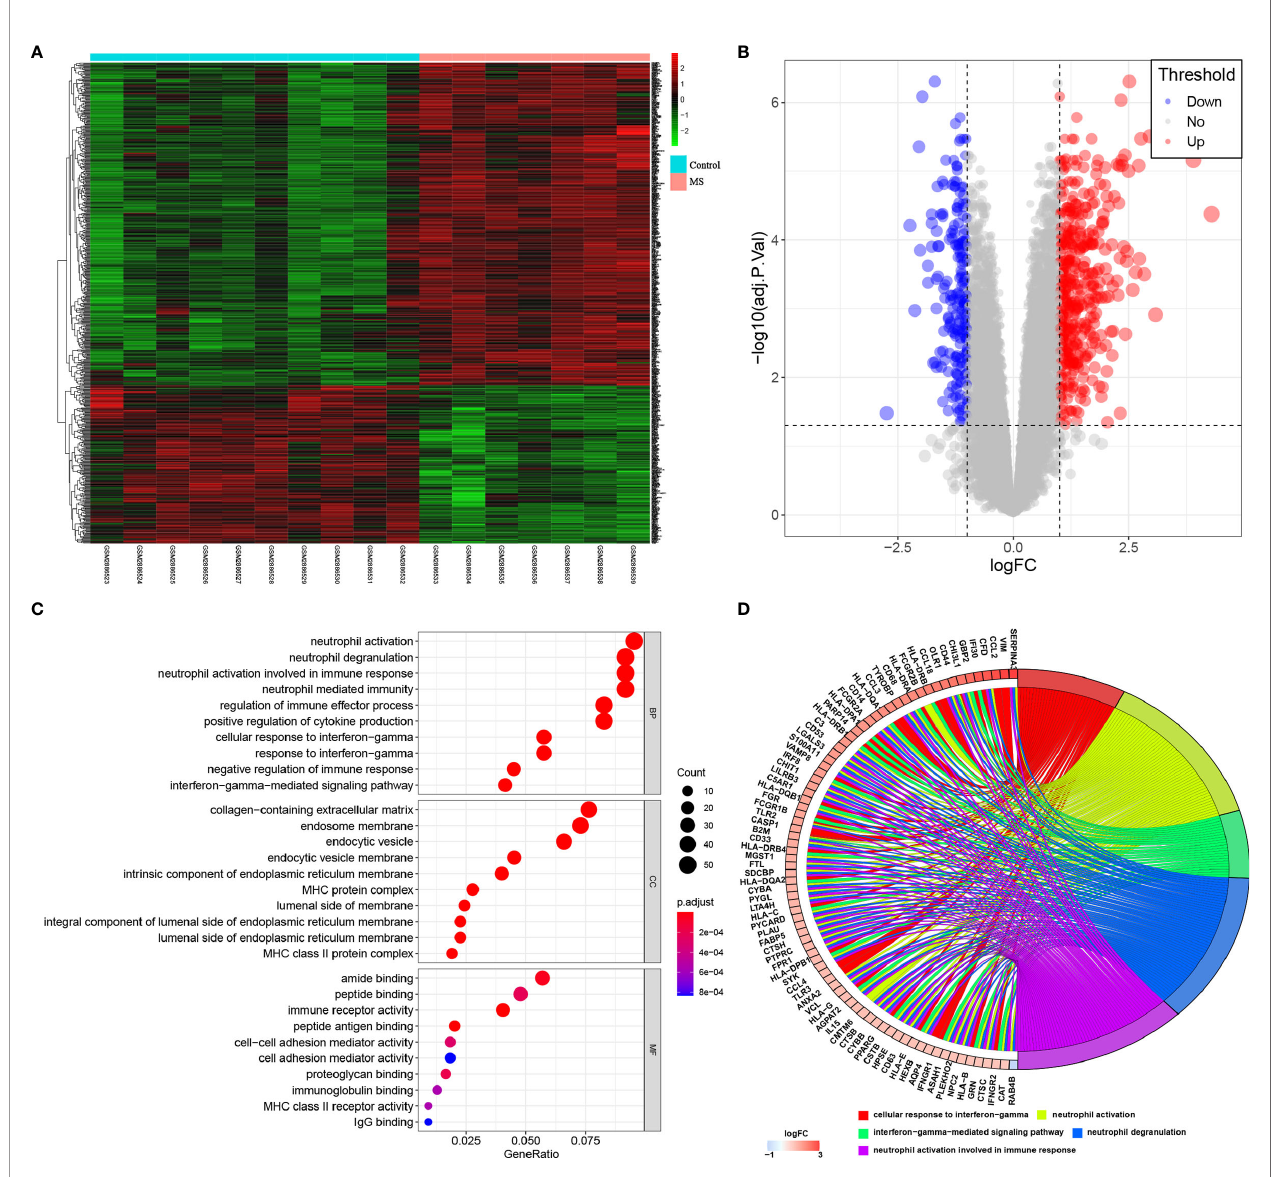
FIGURE 3 | GSE108000 screening of DEGs and GO analysis. (A, B) Heatmap and Volcano Plot of DEGs in MS and control groups. (C, D) The distribution of DEGs in different GO functions, namely, the biological process (BP), cell component (CC) and molecular function